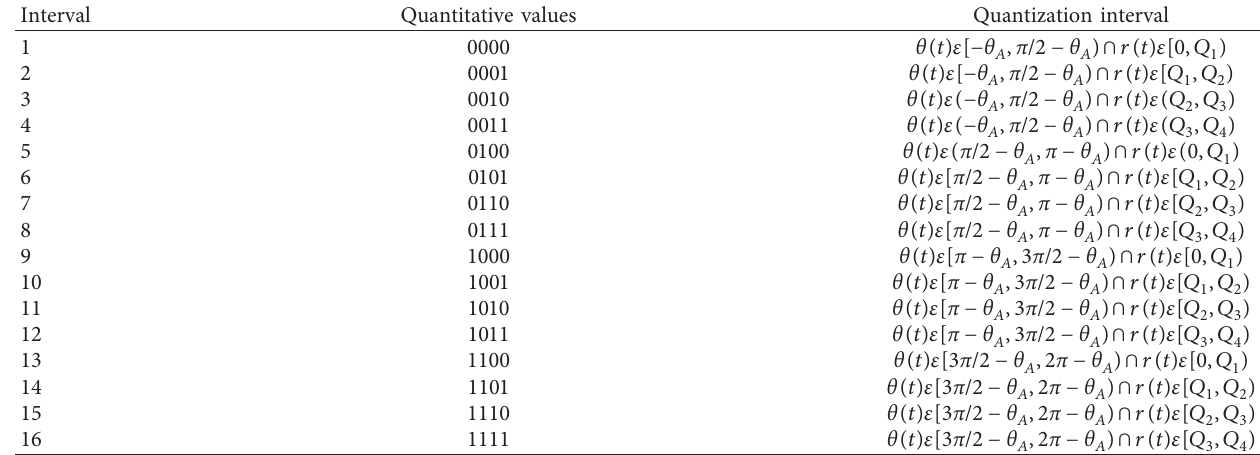
Table 1: Joint quantization scheme of 2bit channel amplitude and 2 bit channel